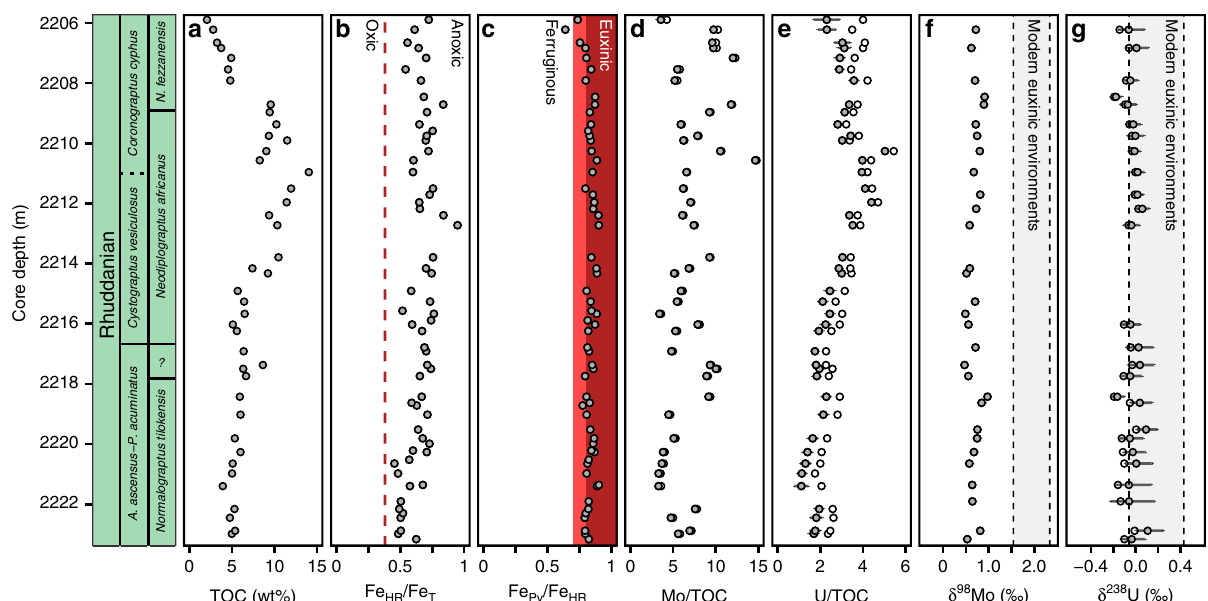
Fig. 1 Geochemistry of the E1-NC174 core. Core depth is presented alongside the global and regional Rhuddanian graptolite biozones based on Loydell 21,22 . a Total organic carbon concentrations (TOC) are presented from Loydell et al. 25 . b Iron speciation highly reactive to total iron ratios; samples with Fe HR / Fe T > 0.38 (dashed red line) are interpreted as anoxic. c Iron speciation pyrite to highly reactive iron ratios; samples with Fe Py /Fe HR > 0.7 – 0.8 are interpreted as euxinic (red box, lighter red = possibly euxinic). d Mo concentrations normalized to total organic carbon concentrations (ppm/wt%). e U concentrations normalized to total organic carbon concentrations (ppm/wt%). f δ 98 Mo illustrated relative to modern euxinic shale range 47 . g δ 238 U illustrated relative to observed modern euxinic/anoxic shale range 44 . In Mo and U concentration and stable isotope plots, white points represent bulk measurements, and gray points represent measurements corrected for detrital input (for molybdenum, the difference between these values is often negligible). Error bars associated with trace metal concentrations illustrate 2 SD uncertainty on crustal concentrations used in detrital corrections. Error bars associated with trace metal isotopes illustrate combined analytical error (2 SE) and 2 SD uncertainty on crustal concentrations used in detrital corrections. Computed error bars for δ 98 Mo (Supplementary Data 1) are generally smaller than the data points illustrated